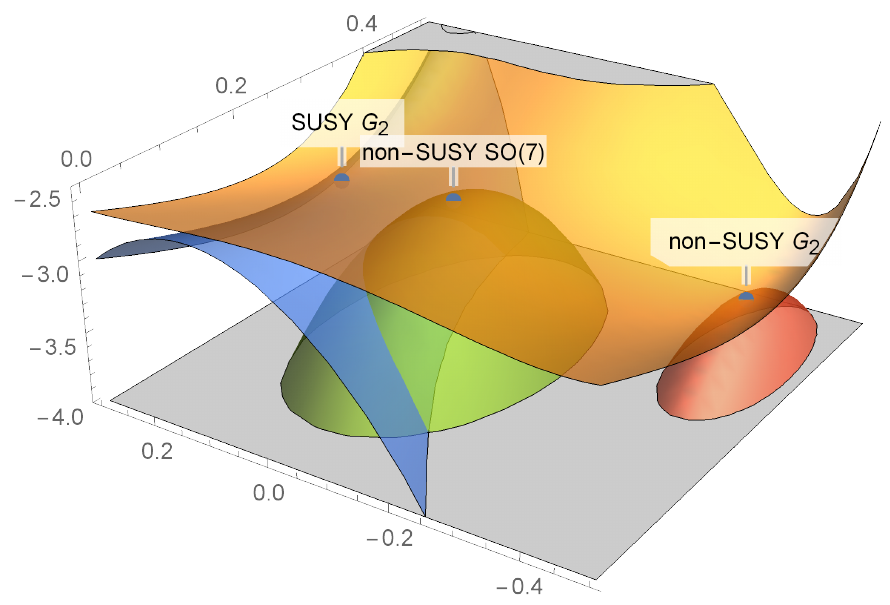
Figure 2. The profile of the scalar potential of G 2 -invariant ISO ( 7 ) gauged supergravity (orange surface), against the three globally bounding functions − 3 f 2 , obtained by solving the PDE (20) through a perturbative expansion around each critical point. The plot is drawn in (cid:96) = 1 units.